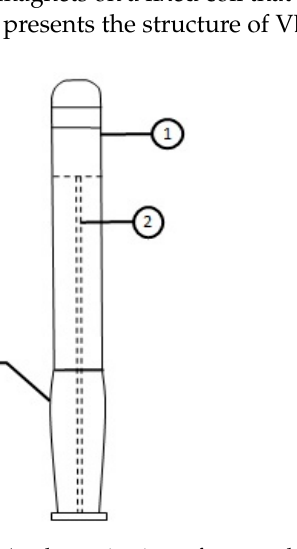
Figure 1. A schematic view of an standard vortex bladeless wind turbine.